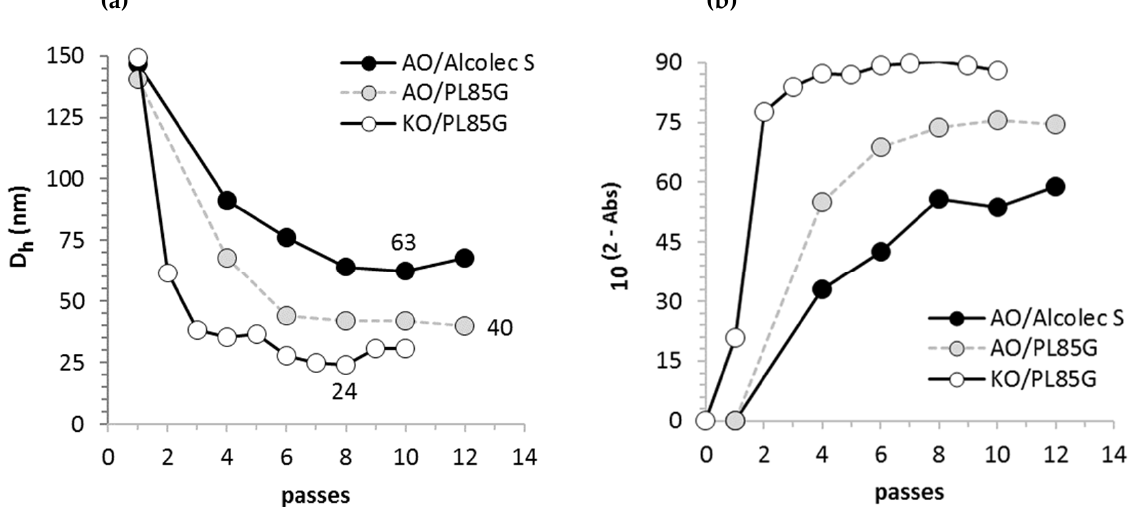
Figure 1. ( a ) Photomicrographs showing AsX/argan oil/PL85G emulsion prepared by rotor-stator homogenization. The mean oil droplet size of the starting material was 5900 ± 3800 nm. Inset shows milky emulsion prepared by rotor–stator homogenization (left) and phase separation that occurs within 48 h (right). ( b ) The same emulsion following UST showing the disappearance of visible oil droplets due to a lipid particle size reduction by nearly two orders of magnitude and below the diffraction limit of visible light. Inset shows stable, clarified nanoemulsion. The bar represents 50 μ m.